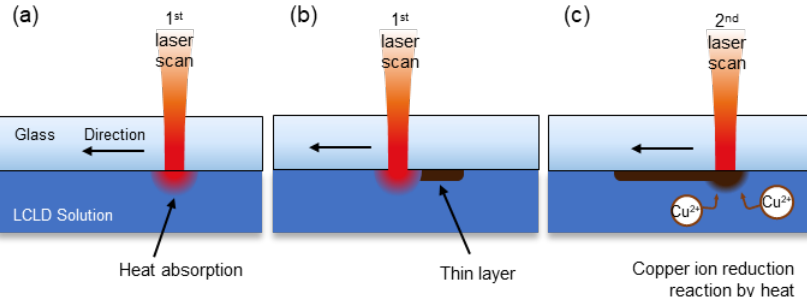
Figure 2. Brief mechanism of the LCLD process. ( a ) The laser beam is absorbed by the solution. ( b ) The